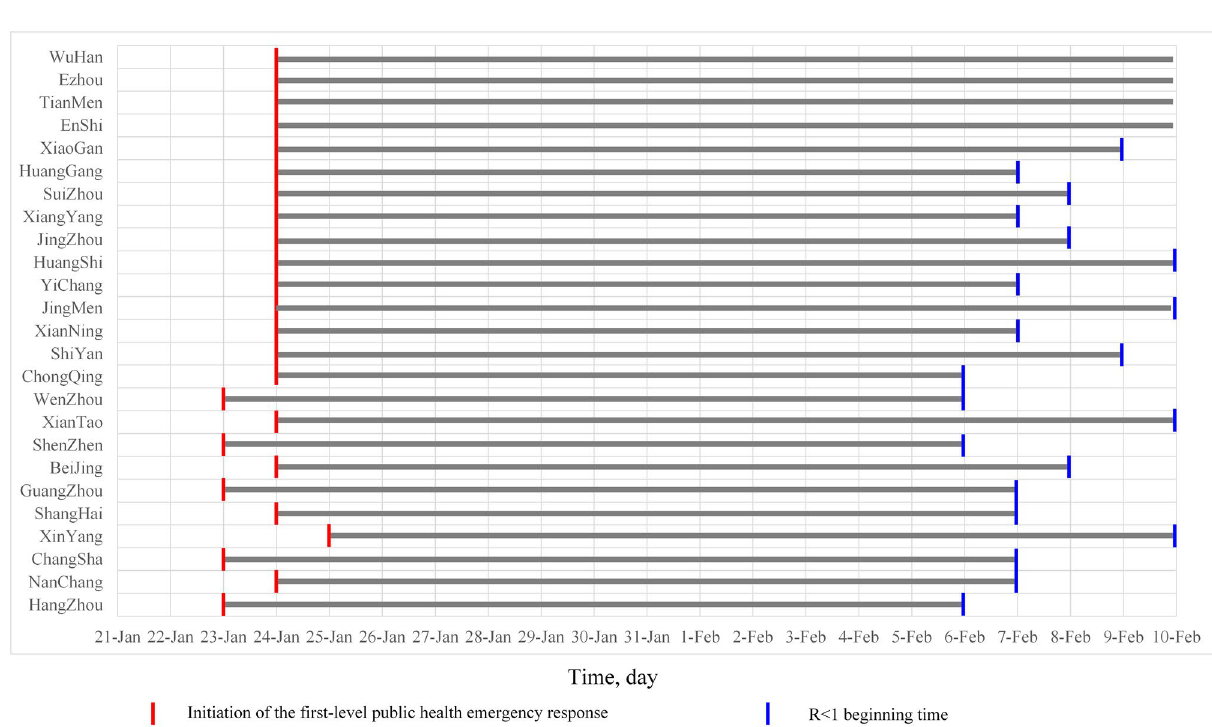
Figure 6. The time at which each city initiated a first-level public health emergency response and the start time for R <